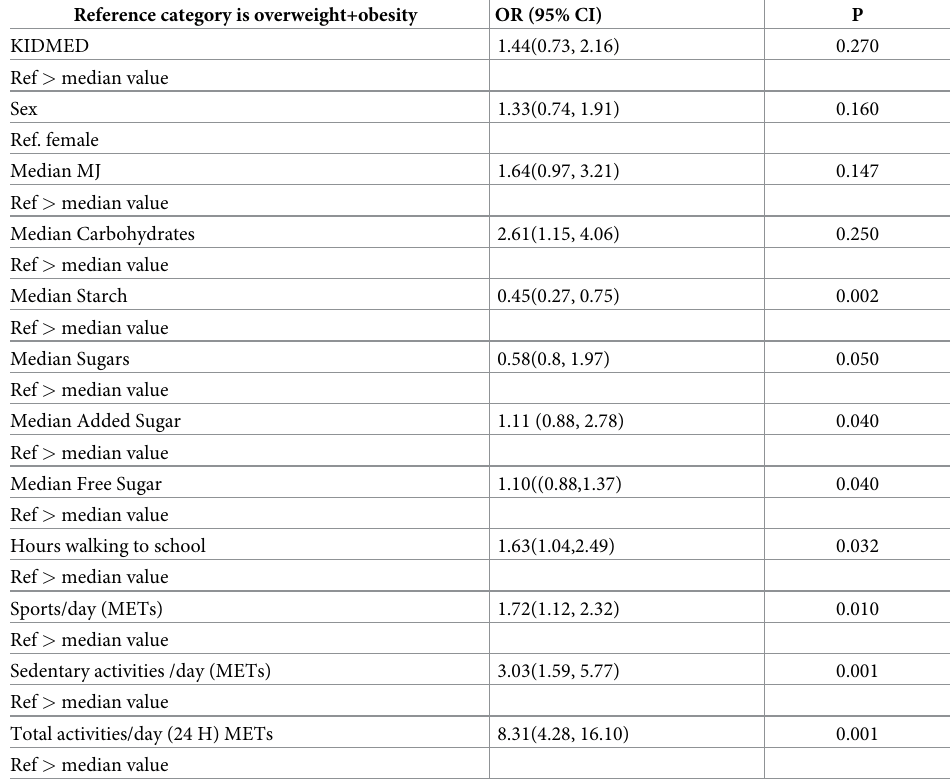
Table 5. Logistic regression analysis to determine factors associated with normal